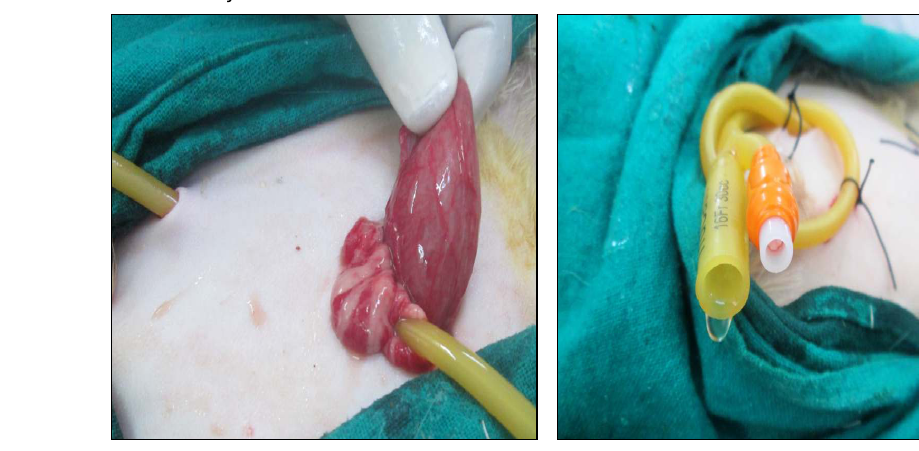
Figure-3: Indwelling Foleys catheter was inserted into subserous ruptured bladder